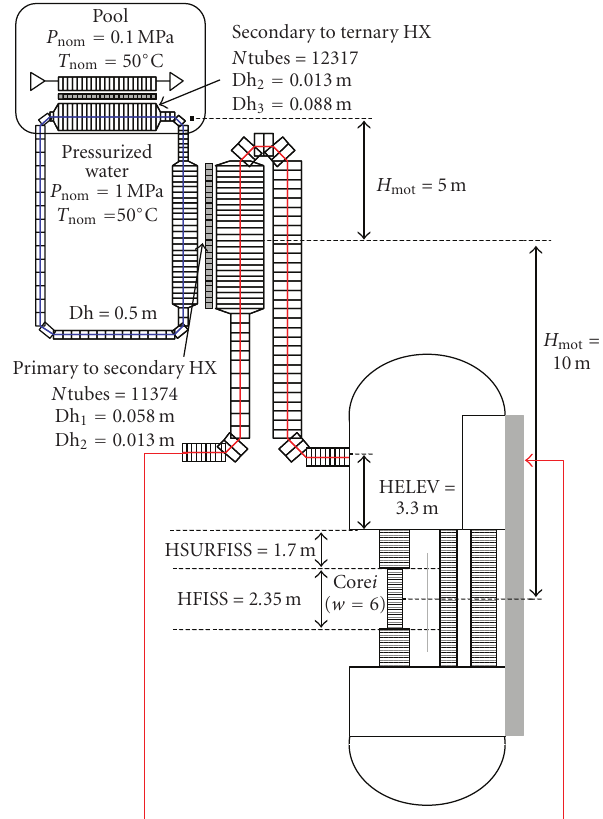
Figure 11: DHR loop features and nodalization in the CATHARE 2 code.